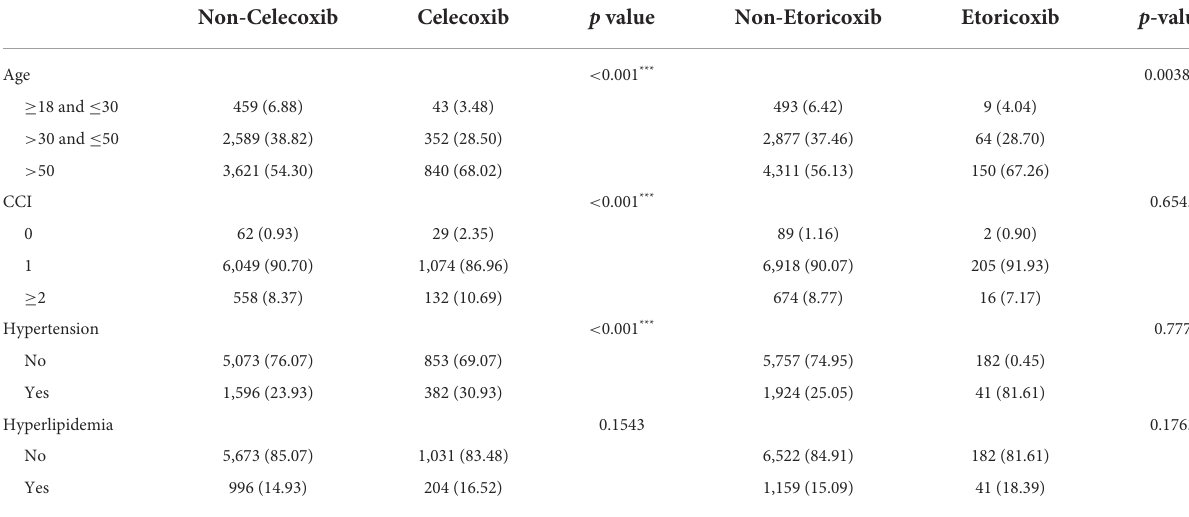
TABLE 1 Cox proportional Hazard model for RA patients, showing the effect of baseline